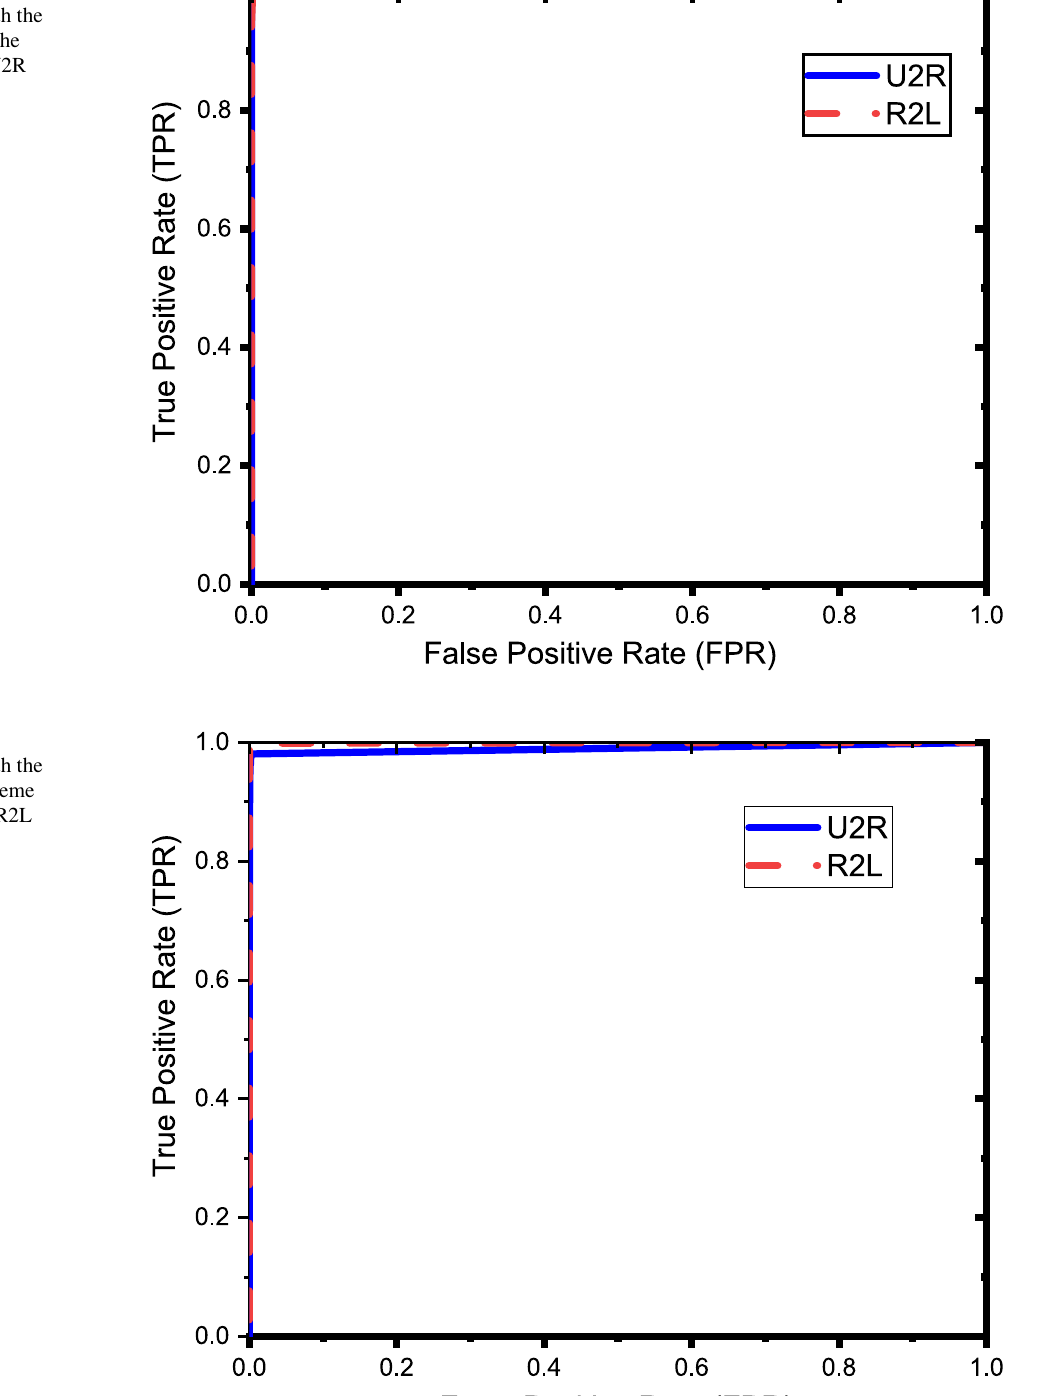
Fig. 7 The ROC curve of random forest classifier with the original dataset for the extreme minority classes U2R and